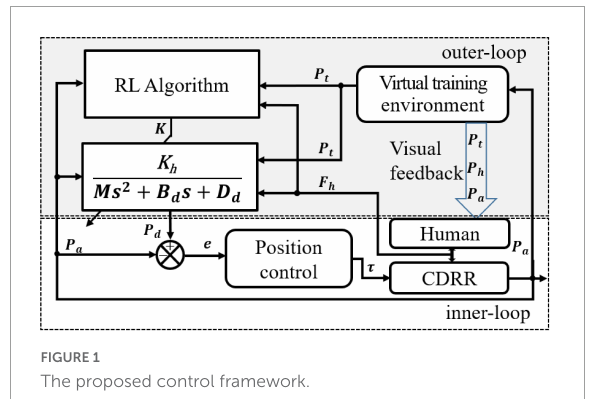
FIGURE1 The proposed control